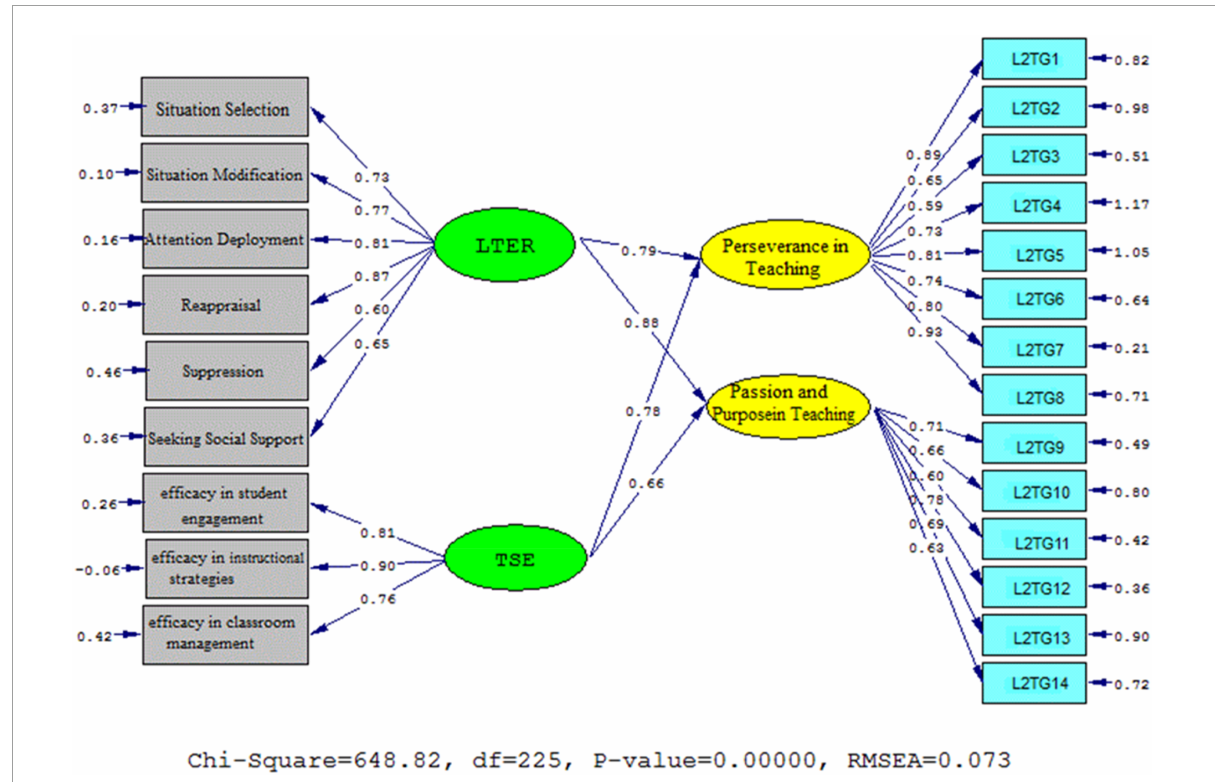
FIGURE4 Schematic representation of path coefficient values for the influential role of ER and self-efficacy on L2 grit (cid:48) subscales (model